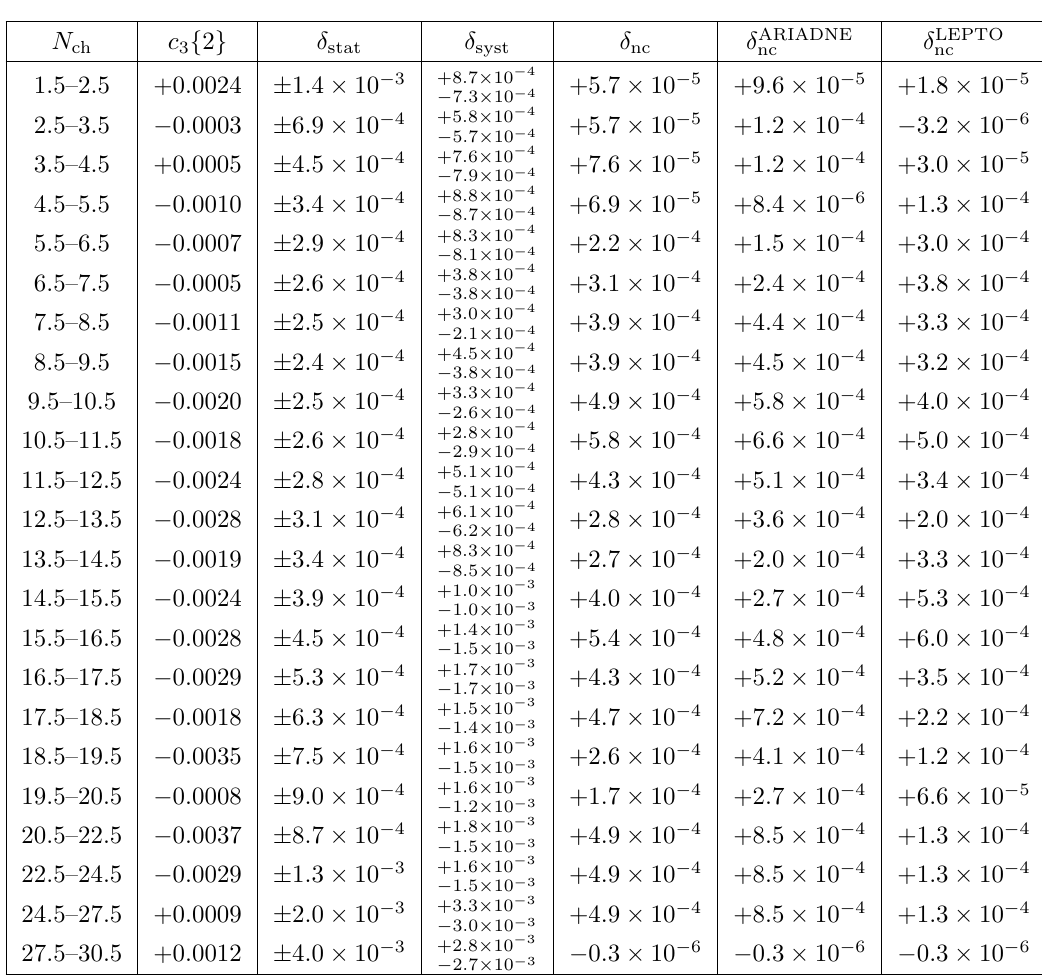
Table 8 . c 3 f 2 g versus N ch from (cid:12)gure 7 (c), p T > 0 : 1 GeV, j (cid:1) (cid:17) j > 2; (cid:14) stat , (cid:14) syst and (cid:14) nc denote the statistical, systematic and Monte Carlo non-closure uncertainties,